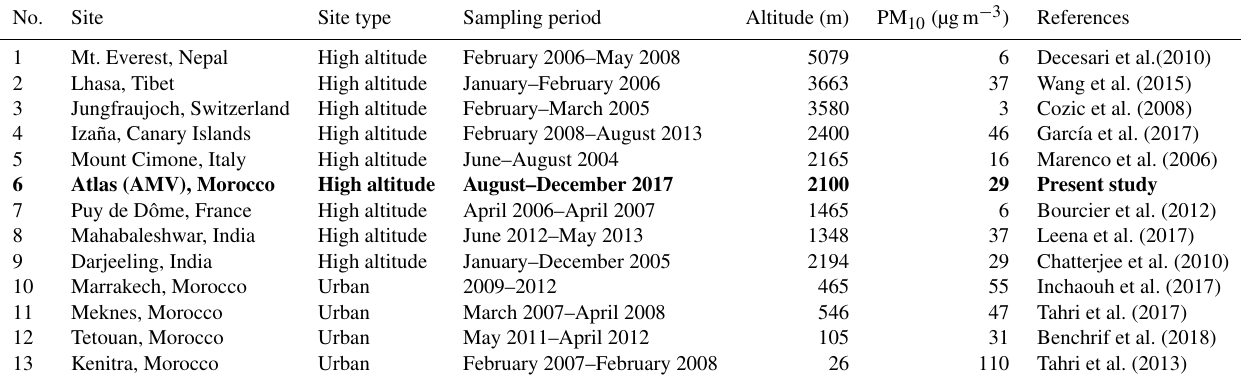
Table 3. Average mass concentration of PM 10 from other high-altitude sites and urban sites in Morocco reported in the literature according to altitude. Data from this study are shown in bold.